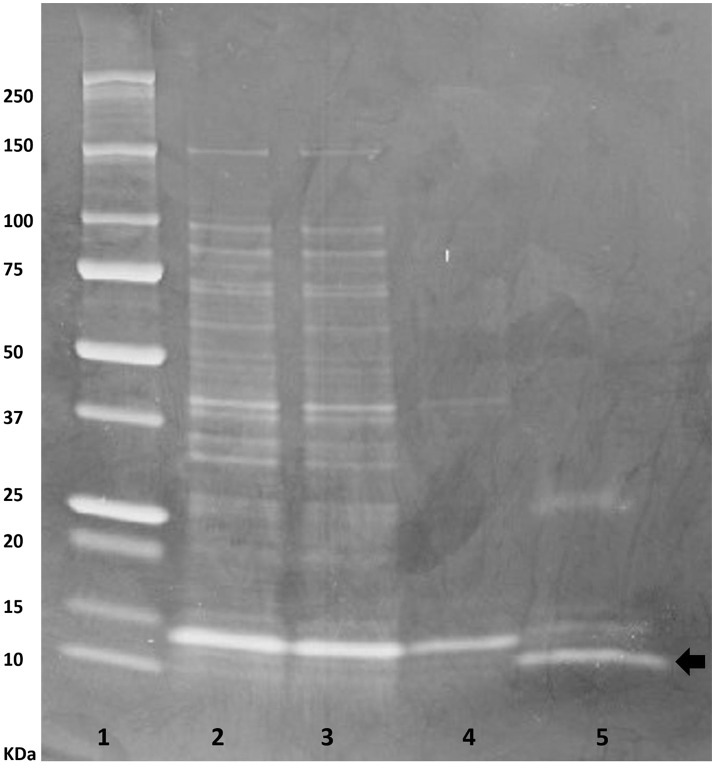
SDS-PAGE analysis of purification steps of buwchitin protein expressed in E. coli TOP10 cells on a 20% denaturing polyacrylamide gel (4 h after induction with 1 mM IPTG). Lane 1, protein molecular weight marker; Lane 2, cell lysate; Lane 3, supernatant; Lane 4, Wash step; Lane 5, eluted buwchitin protein. The arrow indicates band of purified protein of interest. Expected size is 8.35 (±3–4 kDa from His-tag).